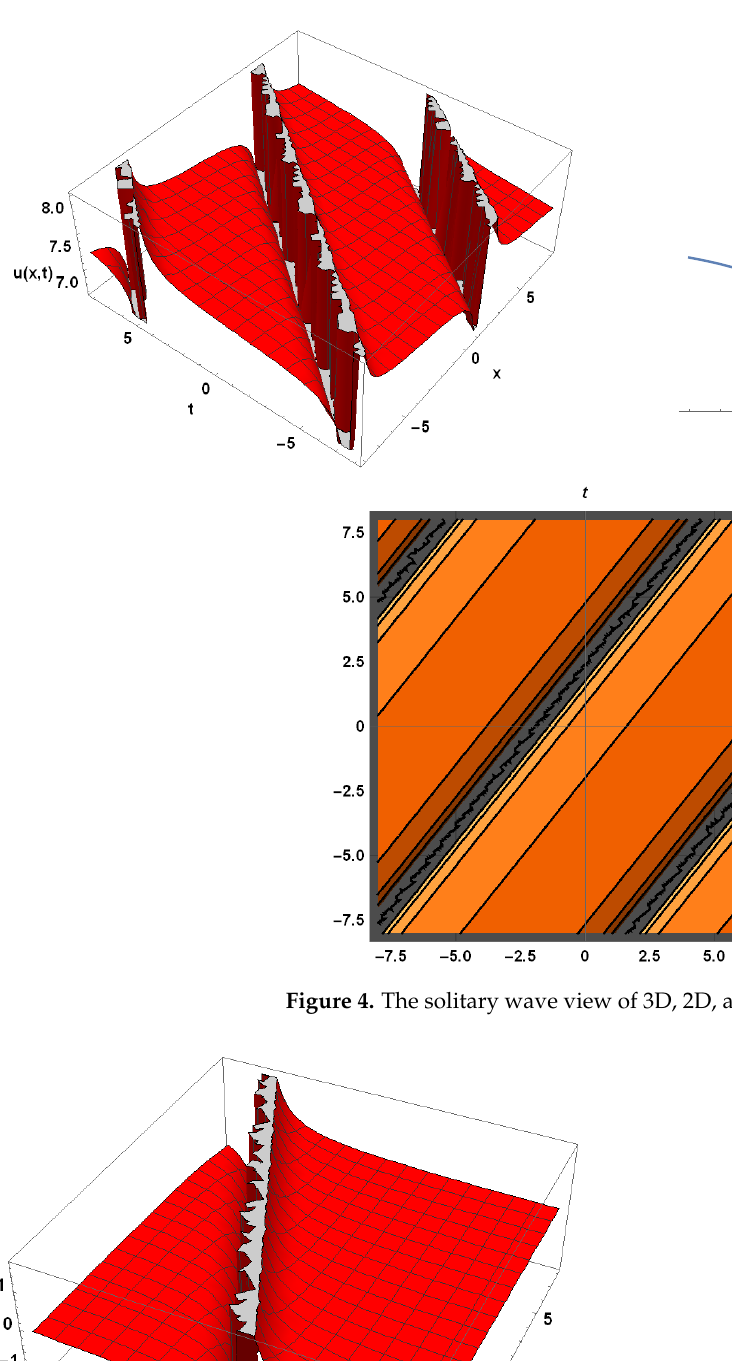
Figure 3. The solitary wave view of the 3D, 2D, and contour plots of U 3 ( x , t ).